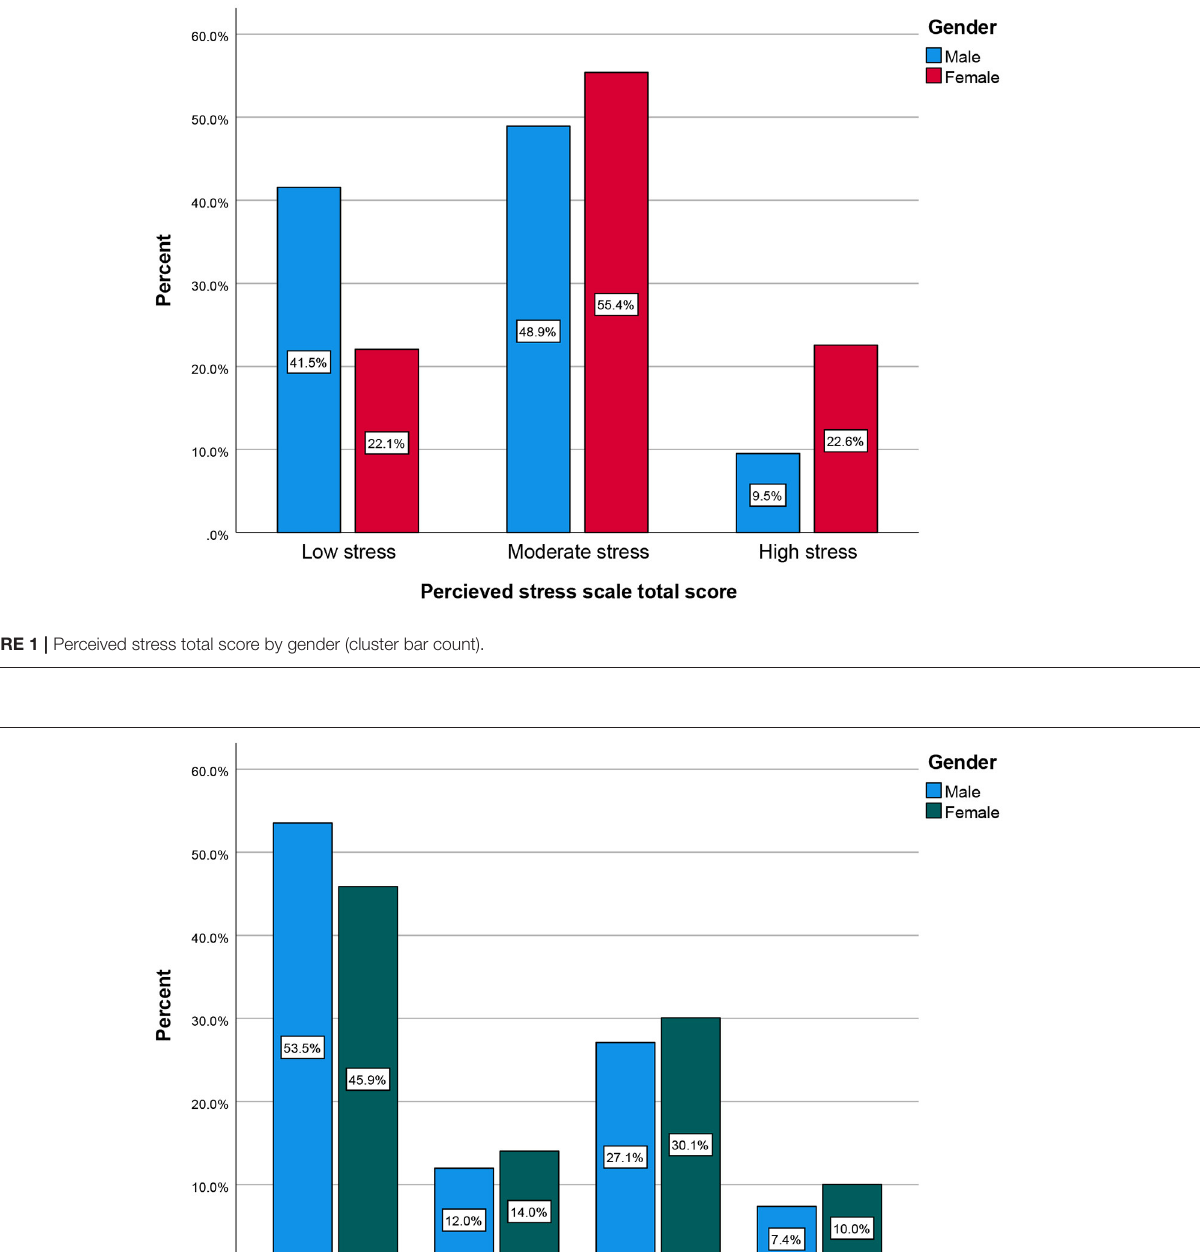
groups ( p = 0.04). For the total depression scores, our analyses revealed a statistically significant association between gender and depression. Female participants were more likely to have higher depression compared to male participants ( p < 0.001).